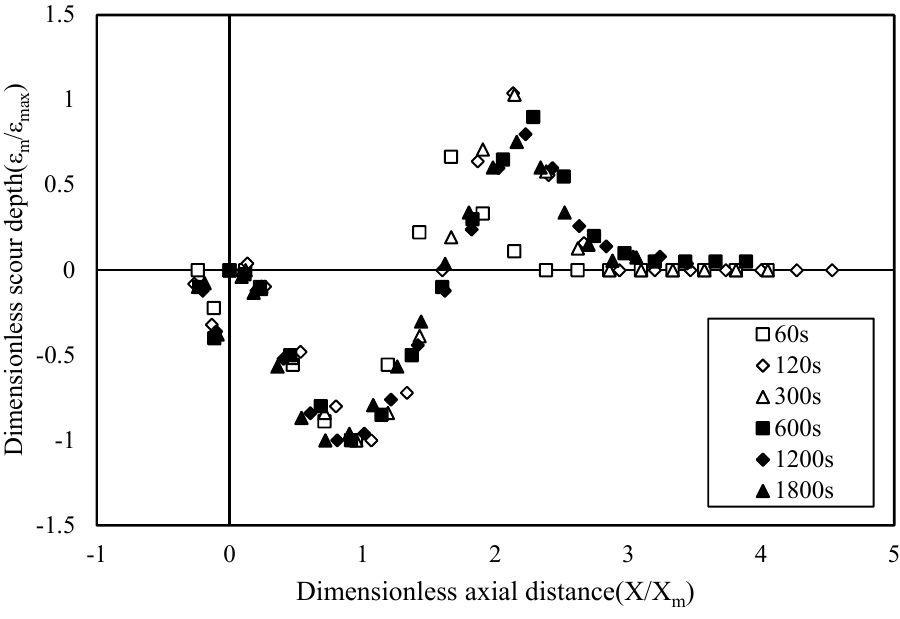
Figure 7. Dimensionless scour depth for a twin-propeller.